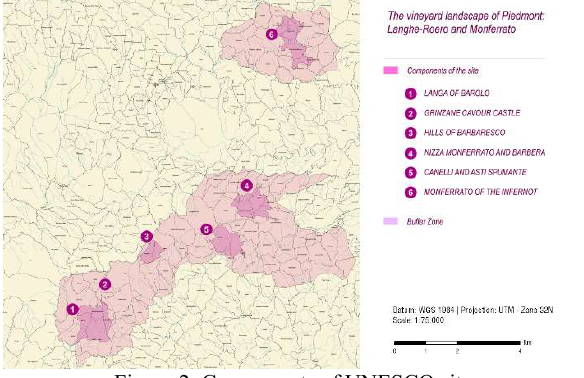
Figure 2. Components of UNESCO site